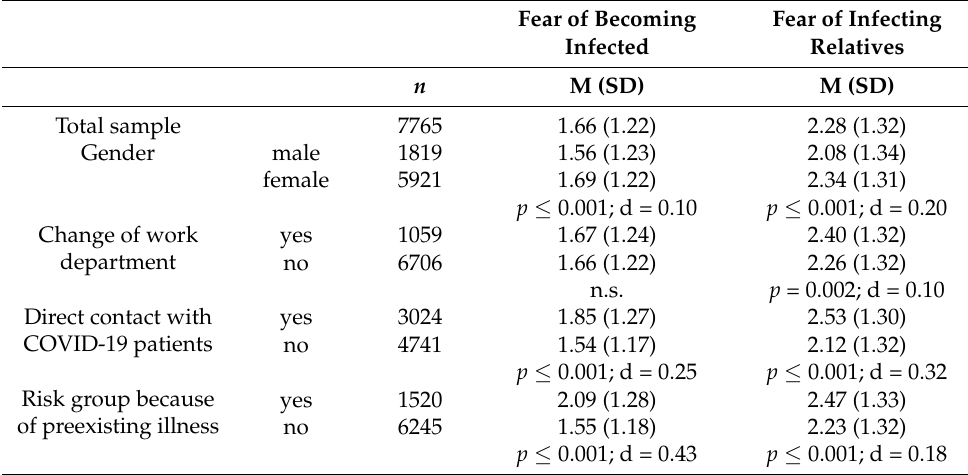
Table 4. Fear of infection among the sample of healthcare workers.